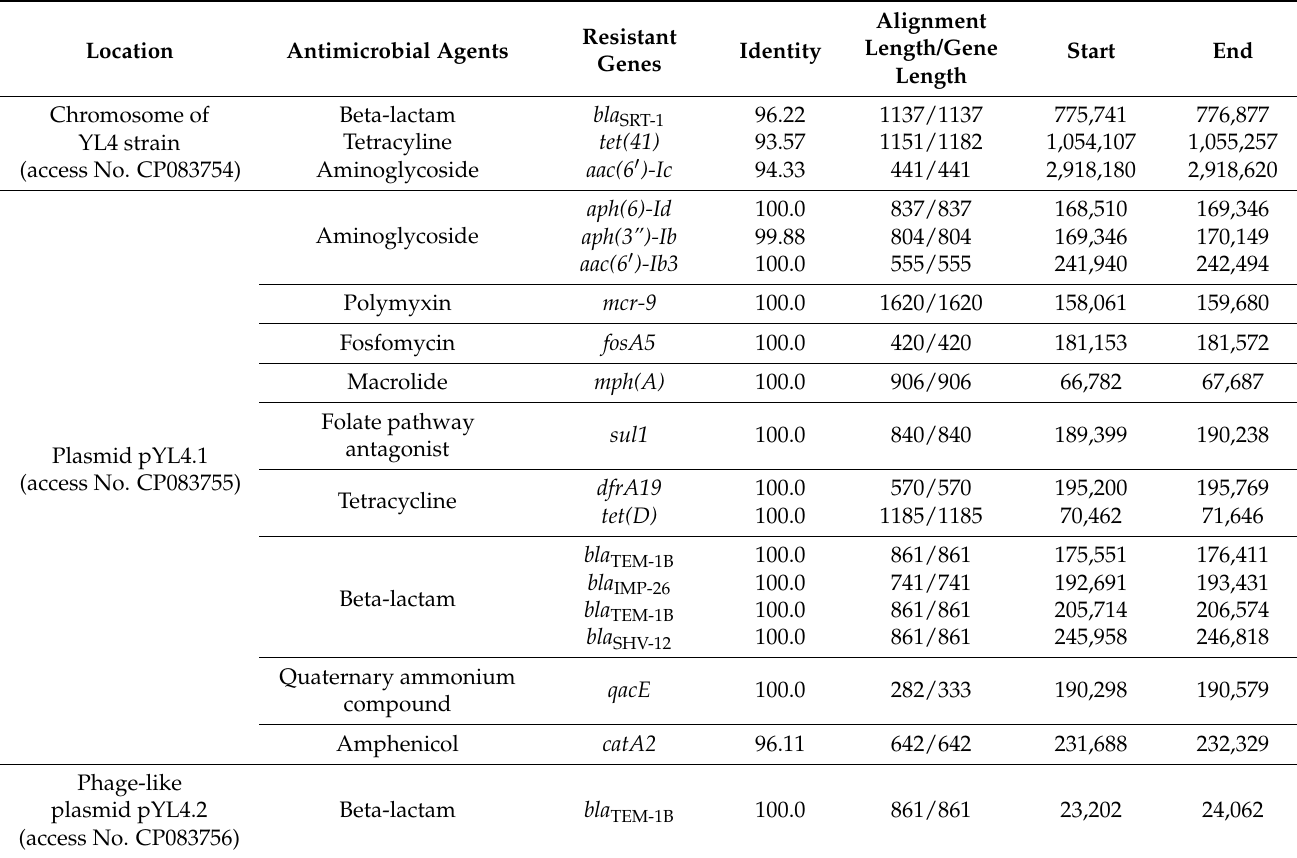
Table 2. Antibiotic resistance genes in S. marcescens